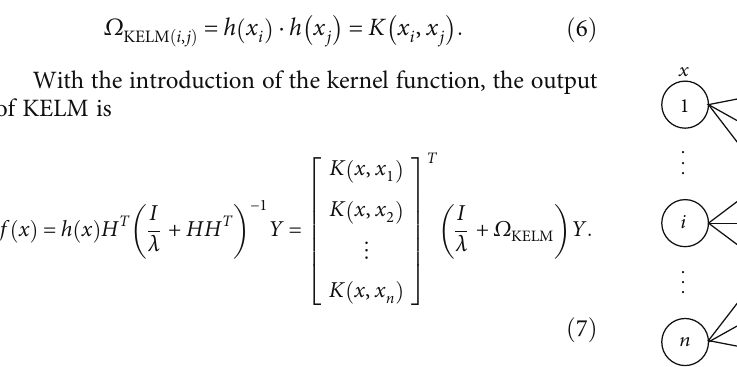
Figure 6: Experimental distribution trend of coalbed methane content. This fi gure counts and plots the distribution range of CBM content in the target block.